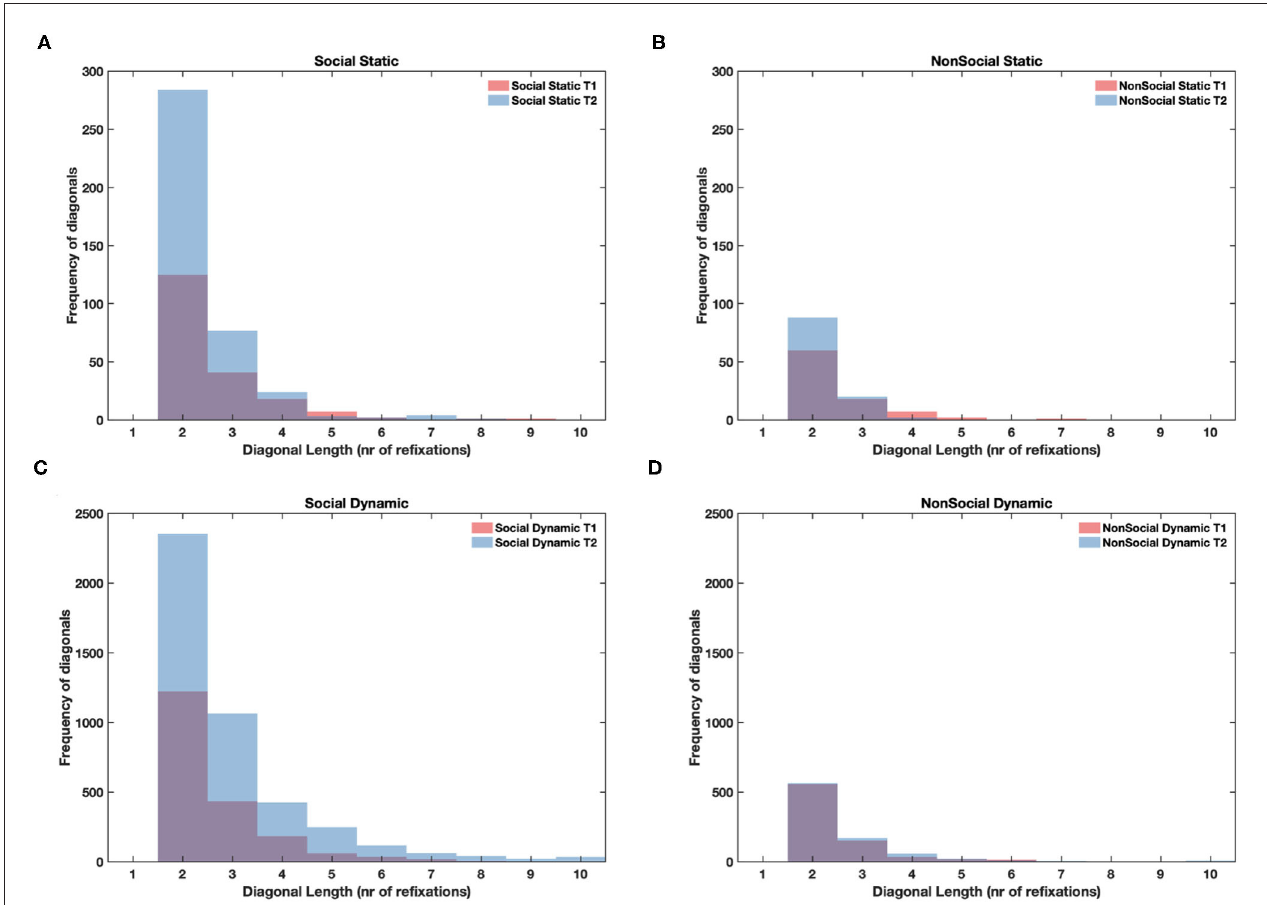
FIGURE 5 | Histograms showing cumulative frequency of diagonal lines of different length (repeated fixation sequences, minimum length of 2 fixations) pooled across all participants for static social (A) , static non-social (B) , dynamic social (C) , and dynamic non-social (D) conditions. T1 values are overlaid on top of T2 values, so purple color indicates the overlap of bars between T1 and